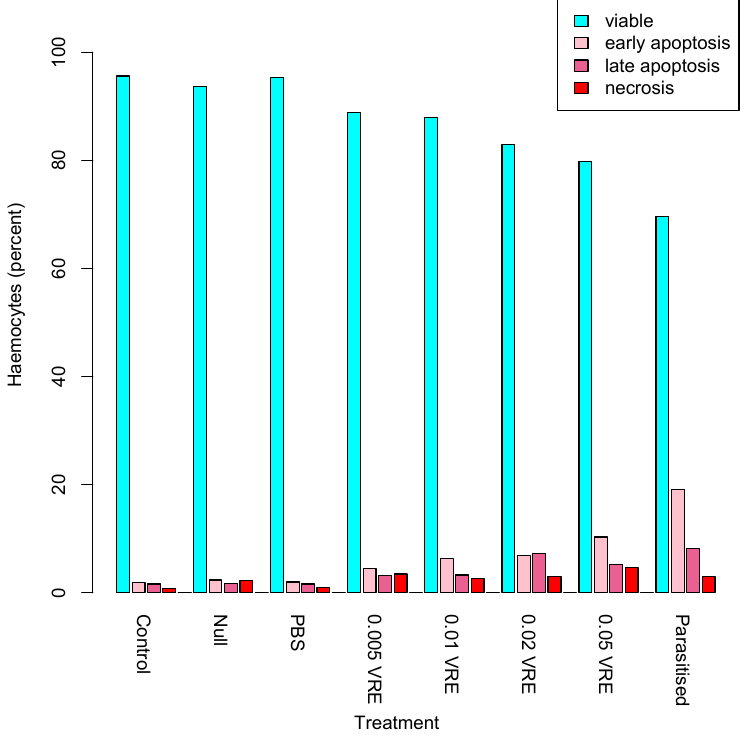
Figure 17. Effect of P. turionellae venom and parasitisation on host, Galleria mellonella haemocyte health and viability (Source: data from [250]).